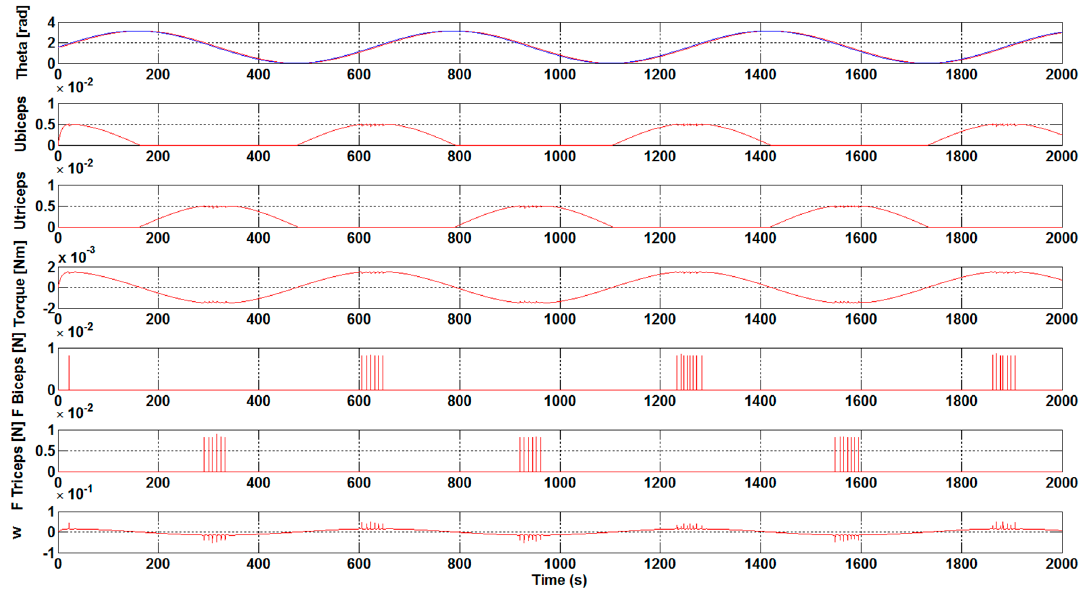
Figure 4. Results without the optimization algorithm and with a K control gain value of 0.3.